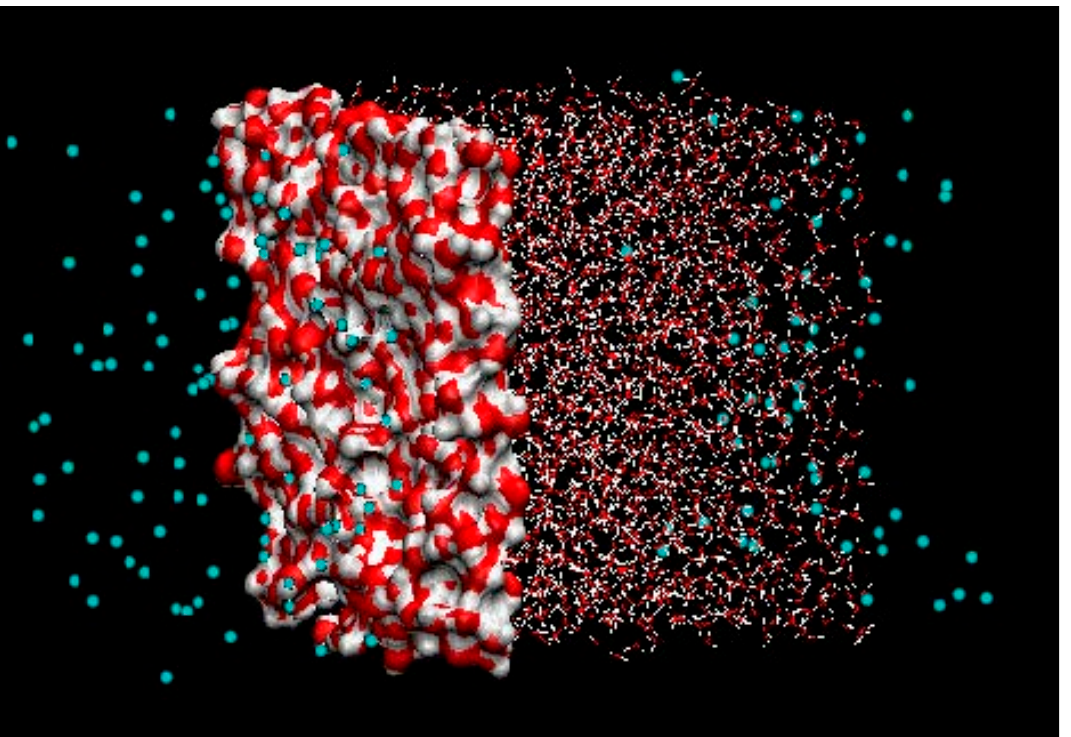
Figure 27. Snapshot of an MD simulation of water (white oxygens and red hydrogens) and methane (green) at 275 K and 65 bar [115].